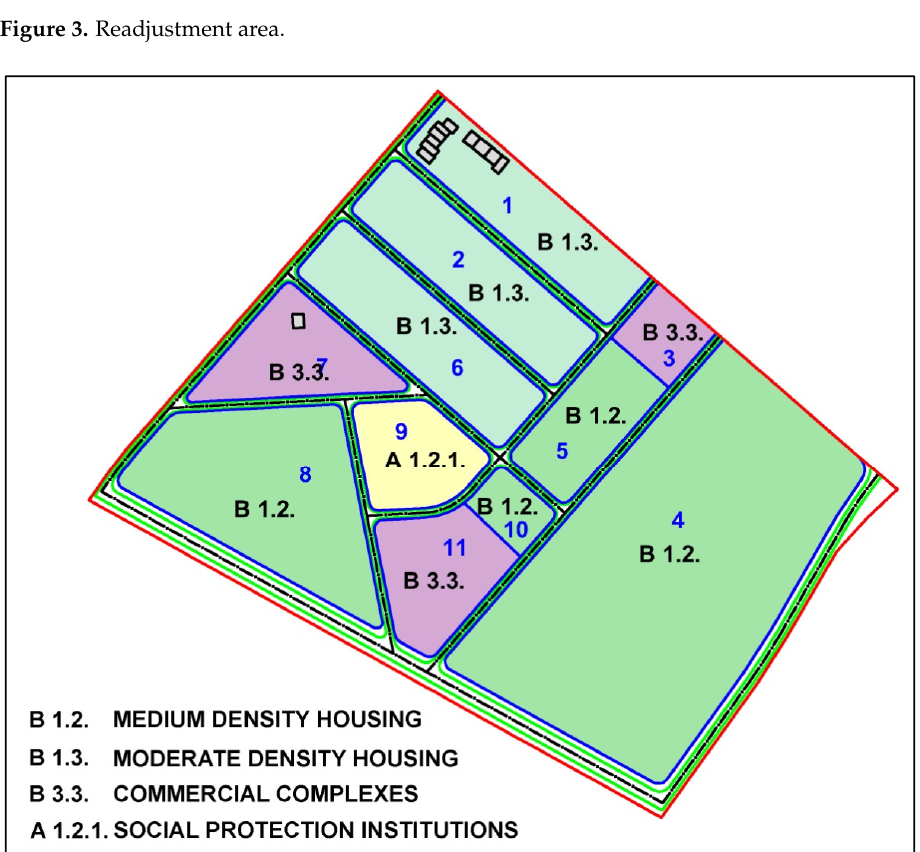
Figure 3. Readjustment area.